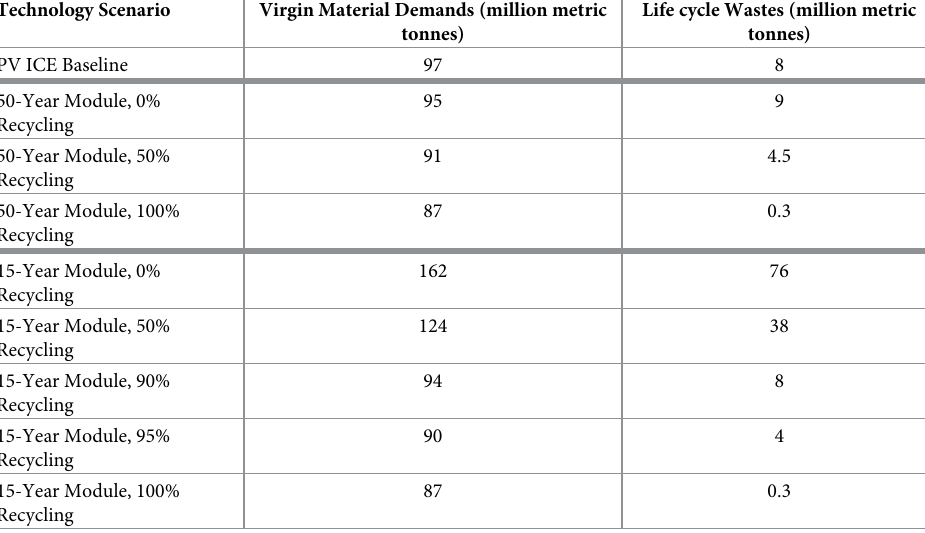
Table 1. Select cumulative virgin material demand and lifecycle wastes. Cumulative 2010 through 2050 virgin material demands and life cycle wastes of selected technology combinations. 100% recycling is closed-loop, which off- sets virgin material